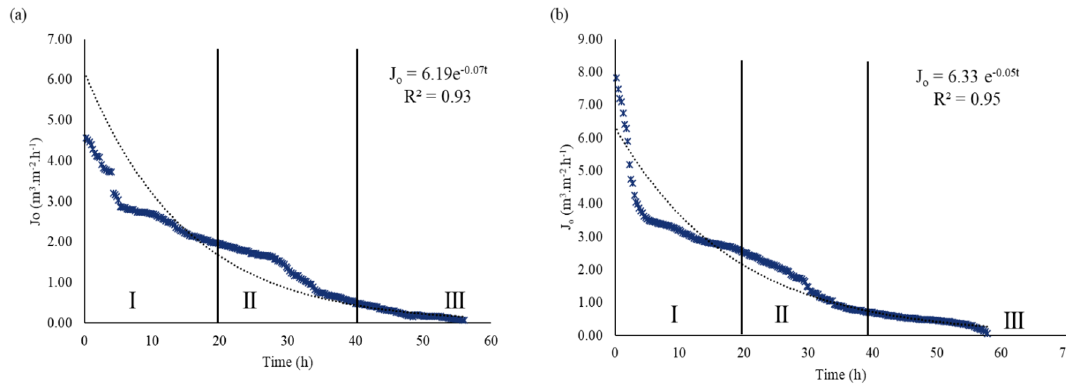
Figure 6. Flux vs time curve for ( a ) AF and ( b ) HFCW